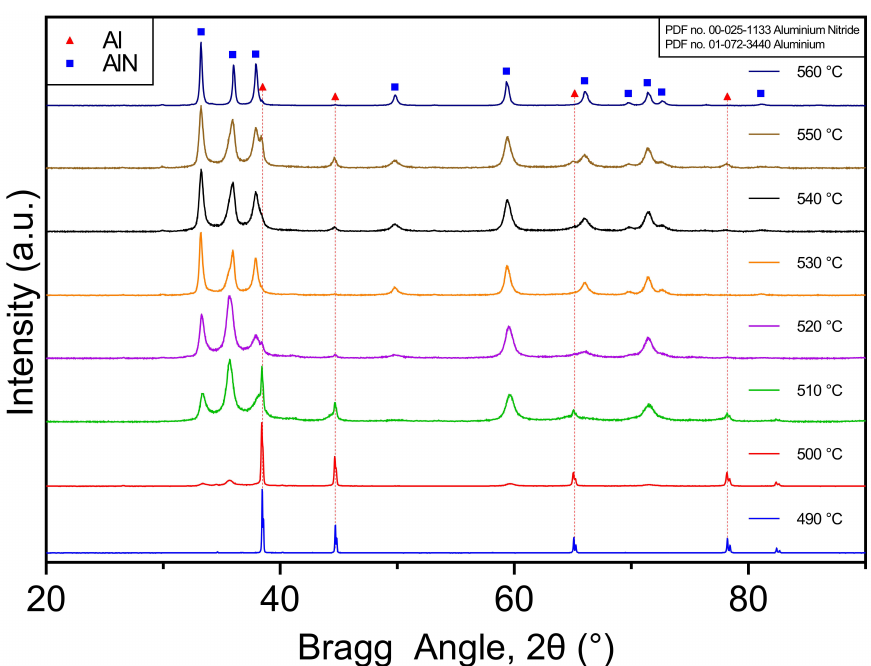
Figure 8. X-ray diffraction spectra from Al powder samples exposed to nitrogen atmospheres for 6 h at temperatures between 490 and 560 °C showing metallic Al peaks and an increasing intensity of peaks associated with AlN with increasing nitridation temperature (PDF no. 01-072-3440 Aluminium, PDF no. 00-025-1133 Aluminium